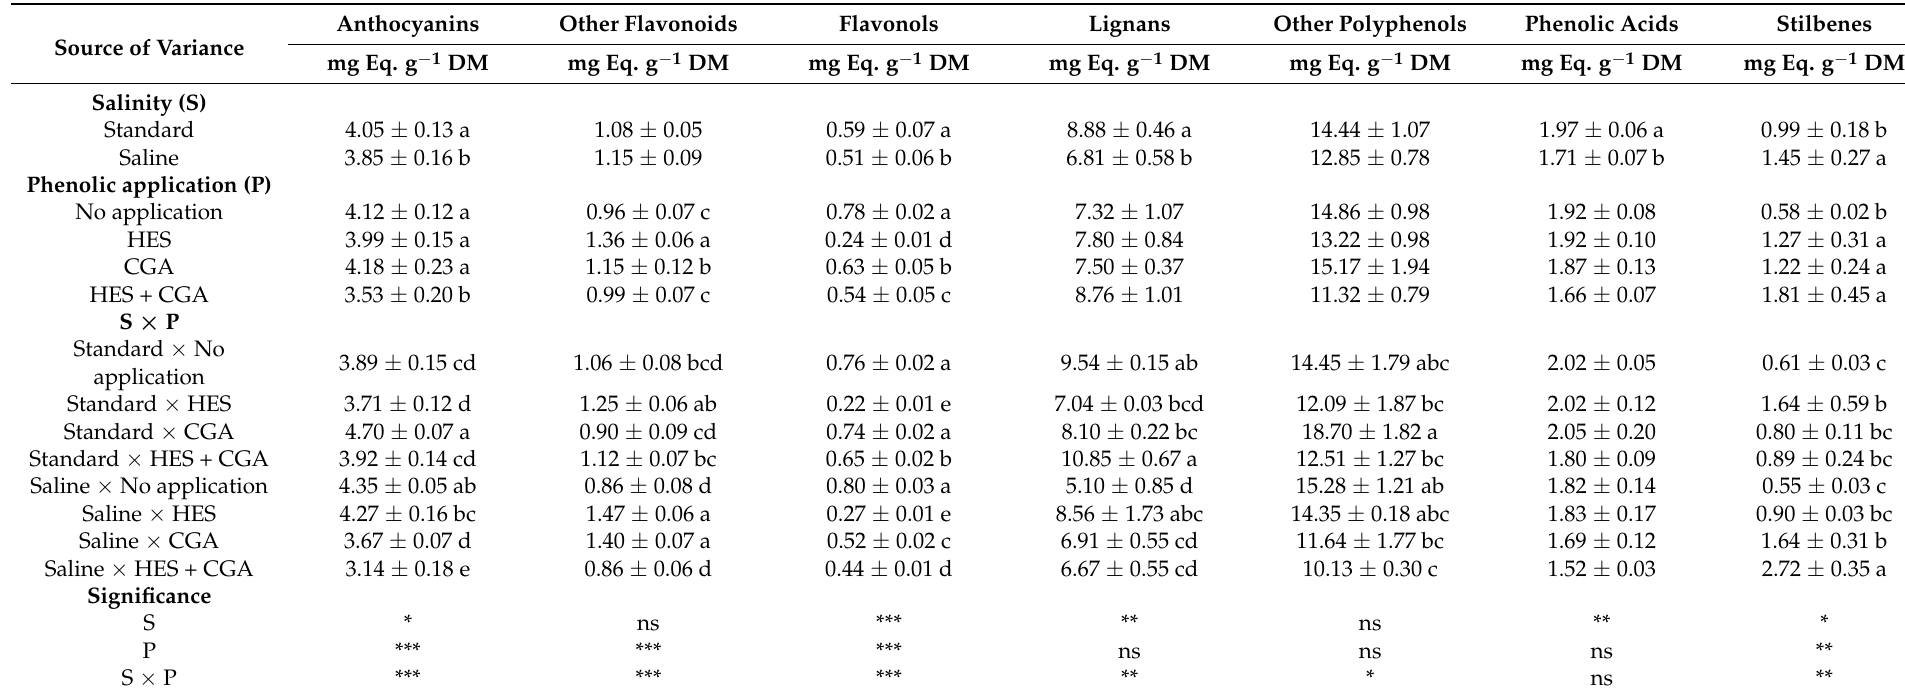
Table 1. Semi-quantitative analysis of methanolic extracts obtained from lettuces treated with: standard non-treated, 100 µ M hesperidin (HES), 50 µ M chlorogenic acid (CGA), and 100 µ M hesperidin + 50 µ M chlorogenic acid (HES + CGA). The treatments were performed both under mild salinity (40 mM NaCl) and non-salt-stress